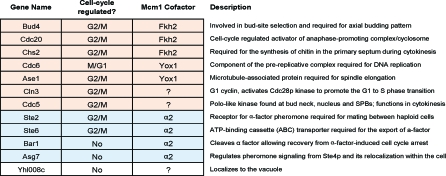
The Ancestral Mcm1-Bound GenesThese twelve genes are targets of Mcm1 in all three species. For each gene, the cell-cycle phase of increased expression [65] (if applicable), the relevant Mcm1 cofactor (if known), and a brief functional annotation is listed. Cell-cycle– and mating-type–regulated genes are shaded orange and blue, respectively.